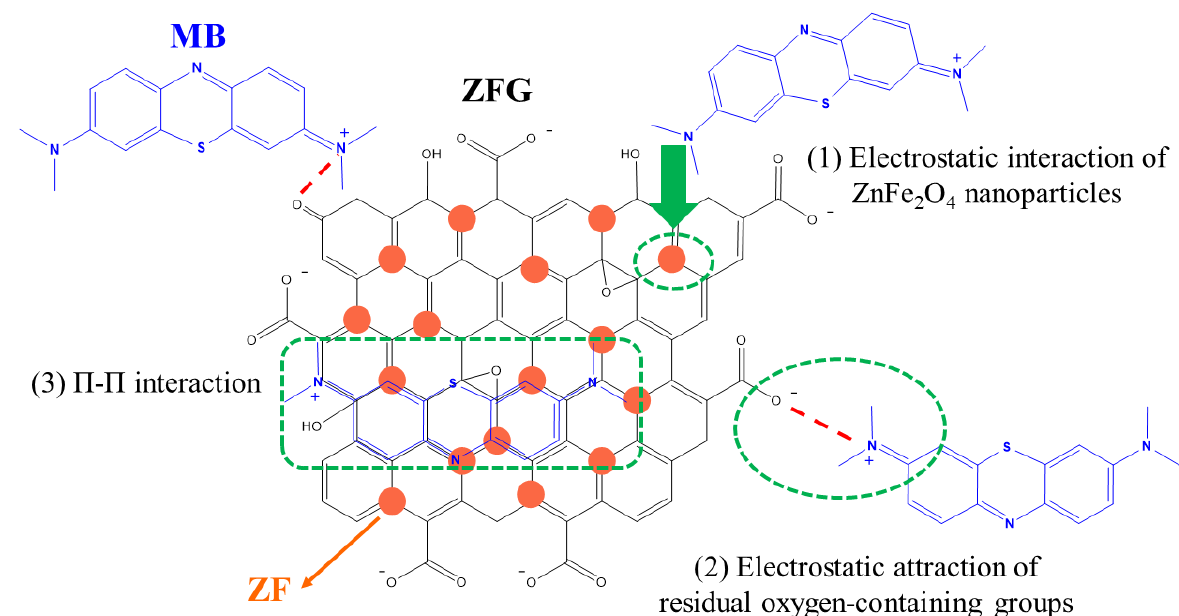
Figure 11. Proposed mechanism of MB dye adsorption on ZFG.